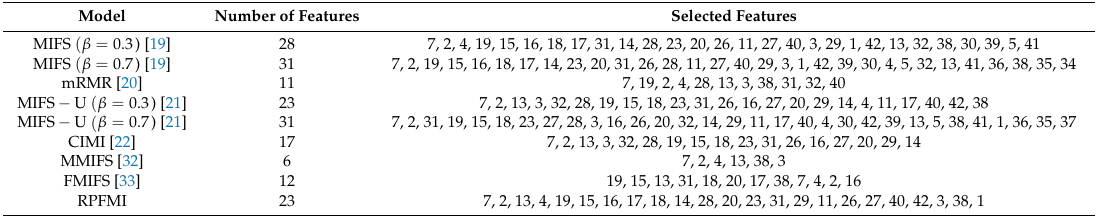
Table 5. Features selected by different feature selection algorithms using the denial of service (DOS) classifier.